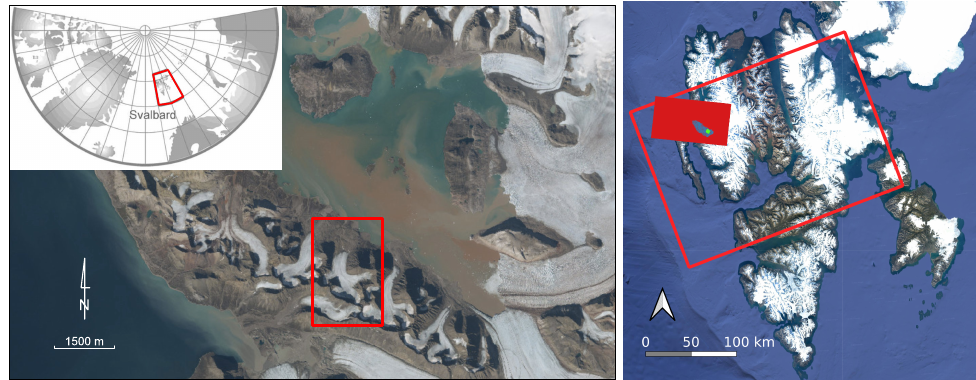
Figure 1. ( Left ): geographical settings. Spitsbergen (top left) is located between 76.5 and 80 ◦ N, with the Brøgger peninsula (background picture: Google, 2020) on the western side of the island between 78.8 and 79 ◦ N. The Austre Lovén glacier basin is highlighted with the red rectangle. ( Right ): Spitsber- gen overlaid with the area covered by one Sentinel-1 spaceborne RADAR dataset. The red rectangle line outlines the dataset provided by the European Space Agency as interferometric wide swath collected over land, with the filled red rectangle restricted to a single burst of a single swath (see text for the definition of these terms) covering the Brøgger peninsula (blue). The Austre Lovén glacier is highlighted as the green dot in the eastern part of Brøgger